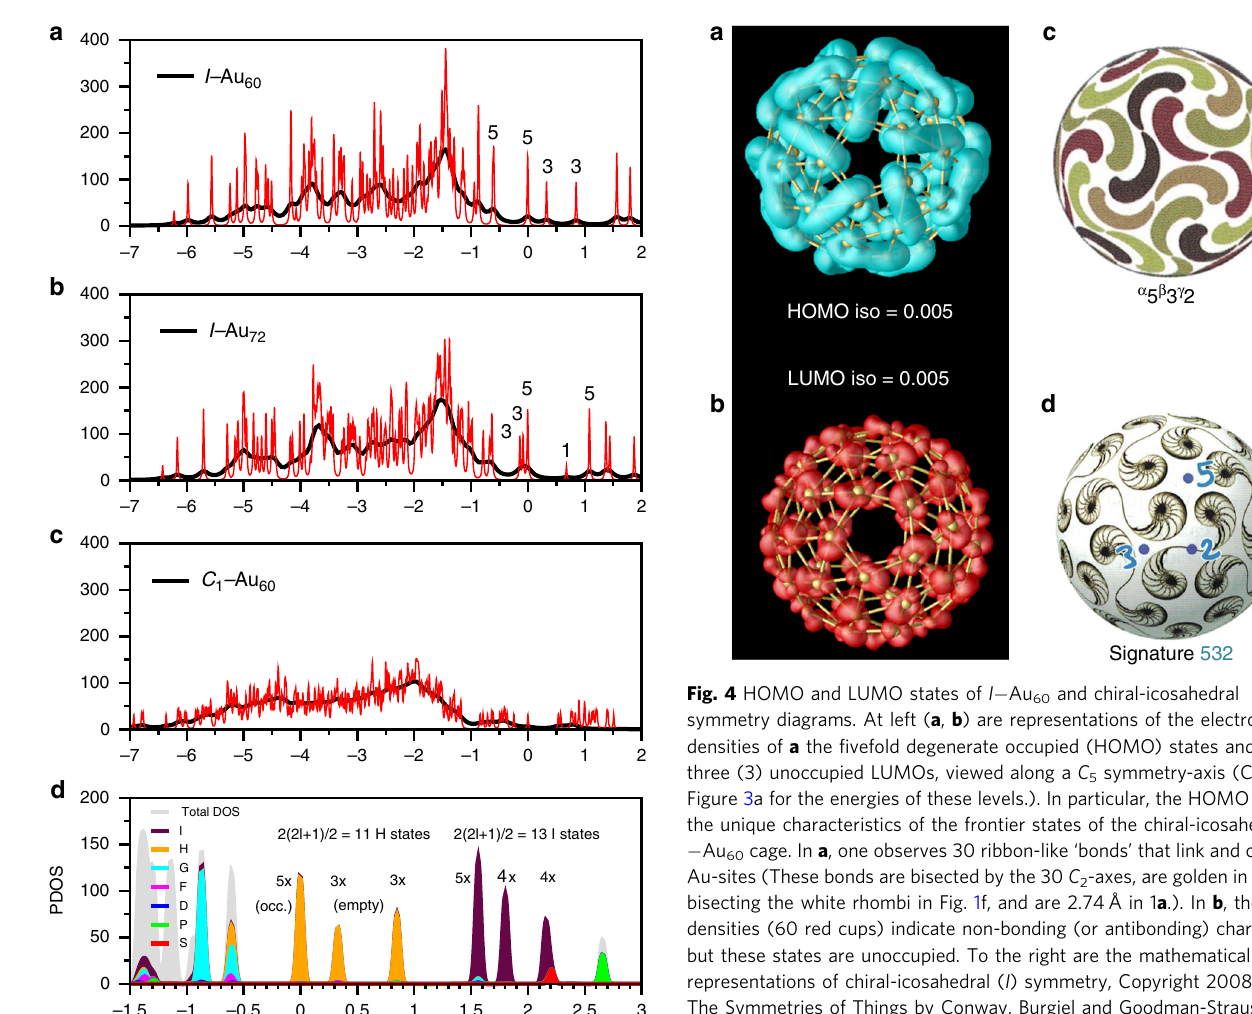
eDOS of the C 1 − Au 60 displays a smeared lineshape characteristic of the low-symmetry 3D Au clusters in this size range 18 , see Fig. 3c. The calculated HOMO-LUMO gap of the I − Au 72 cluster is 0.66 eV, which compares well with the one reported in refer- ence 4 obtained with a similar DFT methodology (0.72 eV). The corresponding HOMO-LUMO gap for the I − Au 60 is smaller (0.32 eV), see below. Figure 3d shows the projected density of states (PDOS) of the I − Au 60 shell. Figure 4a, b shows the HOMO (5) and the LUMO (3) states of the I − Au 60 shell as seen along one of the fi vefold rotation axes for the indicated values of the isosurfaces. This fi gure allows one to visually inspect the pro- found chirality of the frontier electron densities — separately for the set of (5) HOMOs and the set of (3) LUMOs. For the reader ’ s Supplementary Figure 4. convenience, we have added for comparison the diagrams used by mathematicians to analyze chiral icosahedral symmetry 24 , see Fig. 4c, d. The standard interpretation, based on a spherical shell model 25 , indicates that since each Au(0) atom is in the 5 d 10 6 s 1 con fi guration, the neutral N-atom cluster has 10N electrons NATURE COMMUNICATIONS| (2018) 9:3352 |DOI: